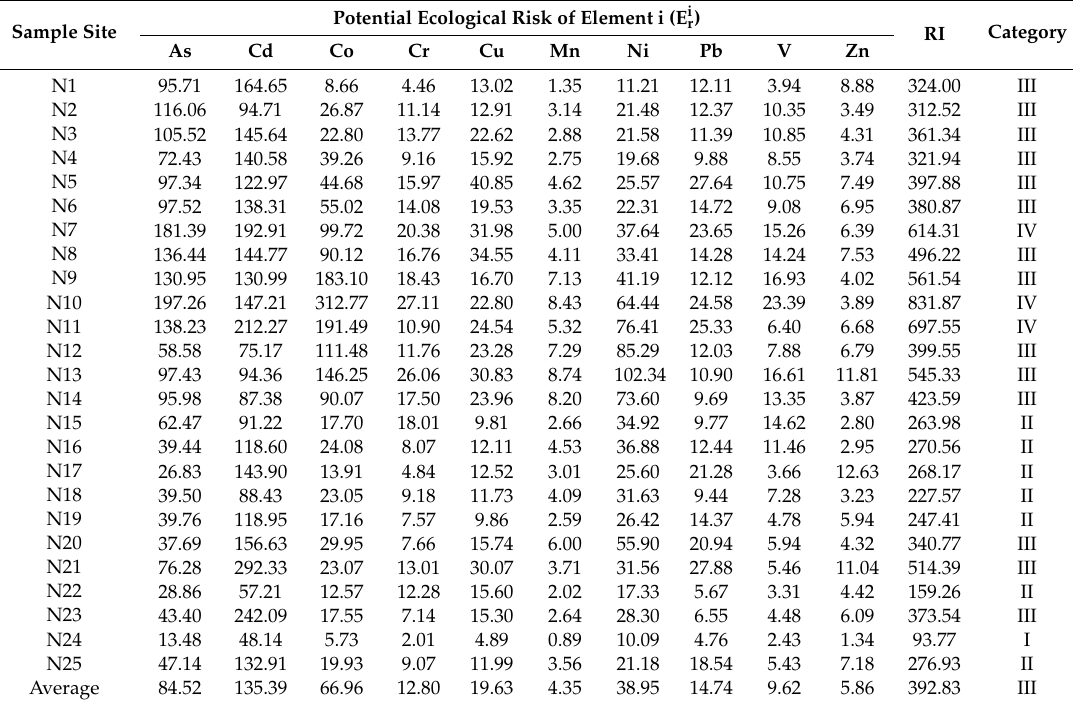
Table 4. Potential ecological risk assessment of atmospherically deposited trace elements by mosses in Wuhan. E i r : the potential ecological risk coe ffi cient of element i; RI: potential ecological risk index of multiple elements. Sample Site